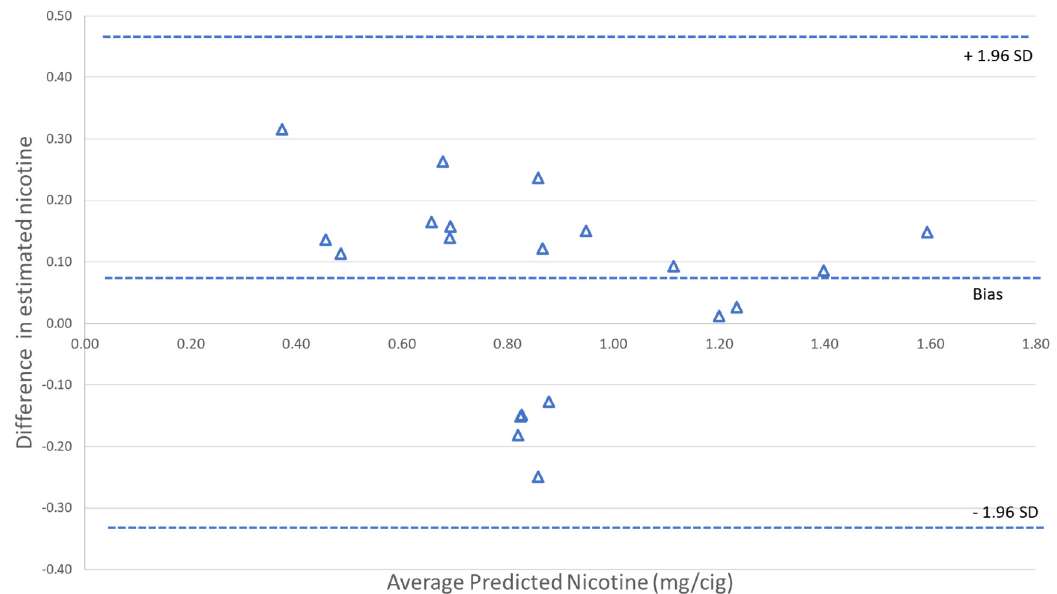
Figure 4. Bland-Altman plots showing agreement between the standard solanesol analytical methodology and the scanner-based luminosity approach for predicting ISO nicotine deliveries for 20 cigarette brands. Δ = Difference in estimated nicotine (X solanesol – X scanner ).